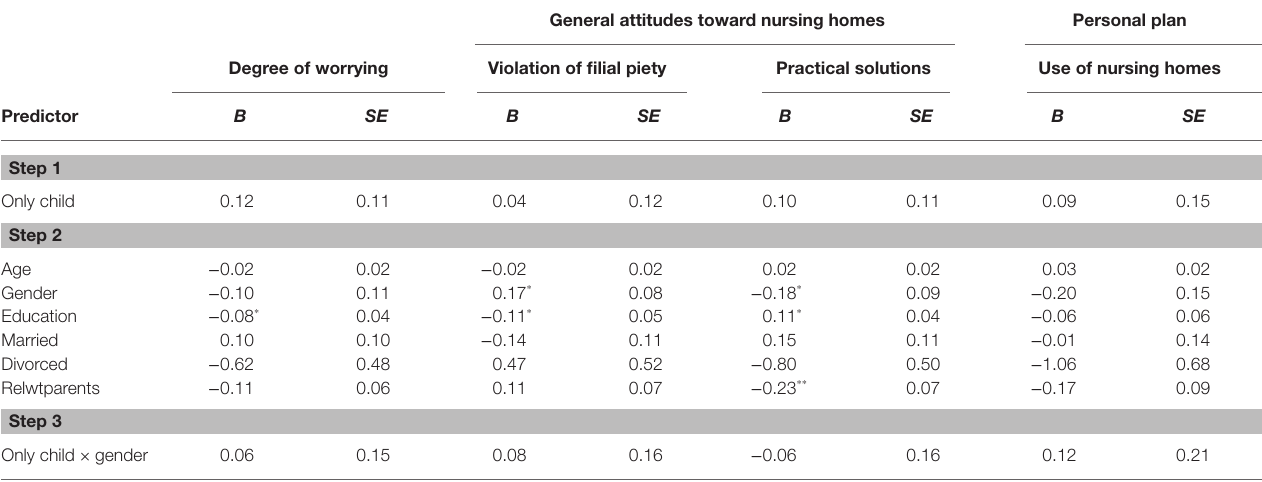
TABLE 3 | Regression analyses predicting degree of worrying and attitudes toward nursing